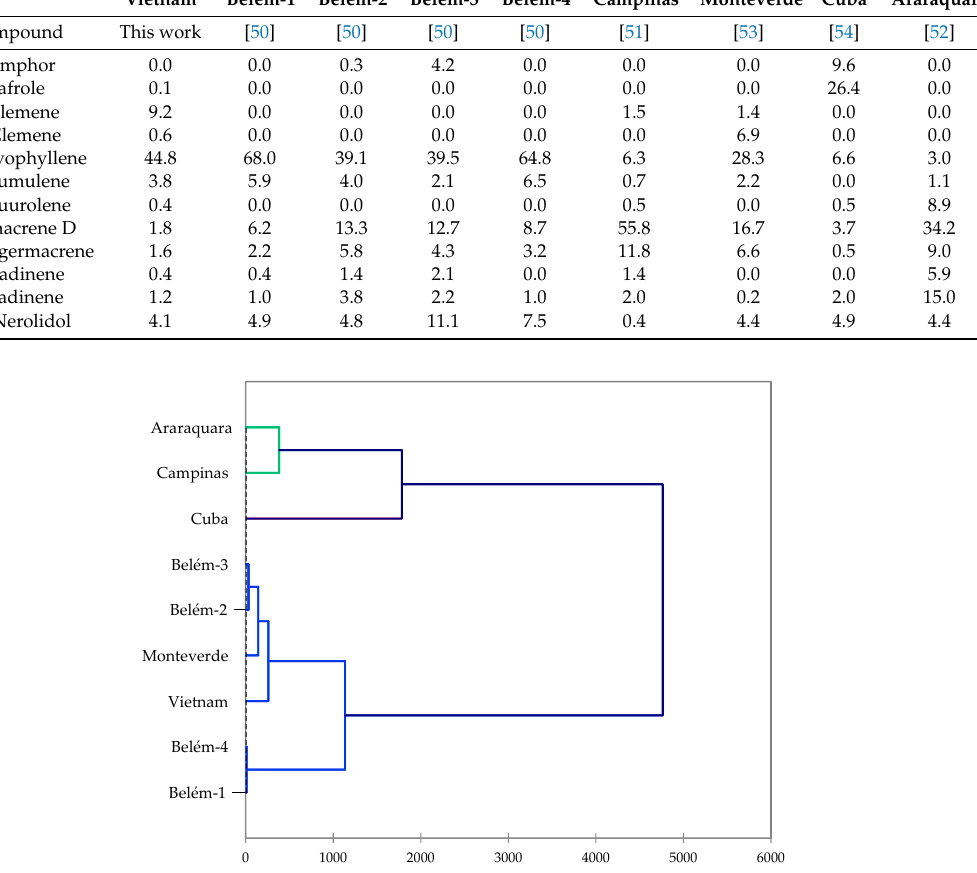
Figure 1. Agglomerative hierarchical cluster analysis based on the major components in Piper umbellatum essential oils.